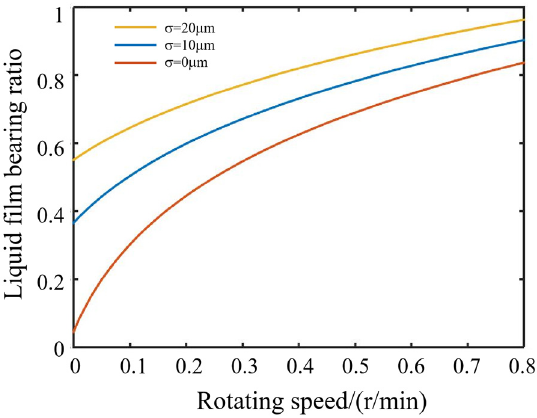
Figure 6. Relationship between liquid film bearing ratio and velocity under different roughness.